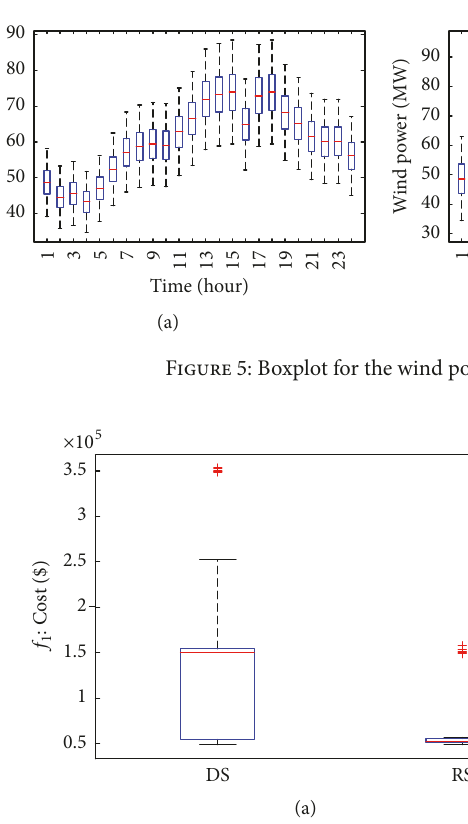
DS are larger than the penalty coefficient 𝐶 (1 𝐸 5). However, the 𝑓 1 and 𝑓 2 values of the Pareto front in Figure 4 with a 10% WP error are smaller than the penalty coefficient 𝐶 (1 𝐸